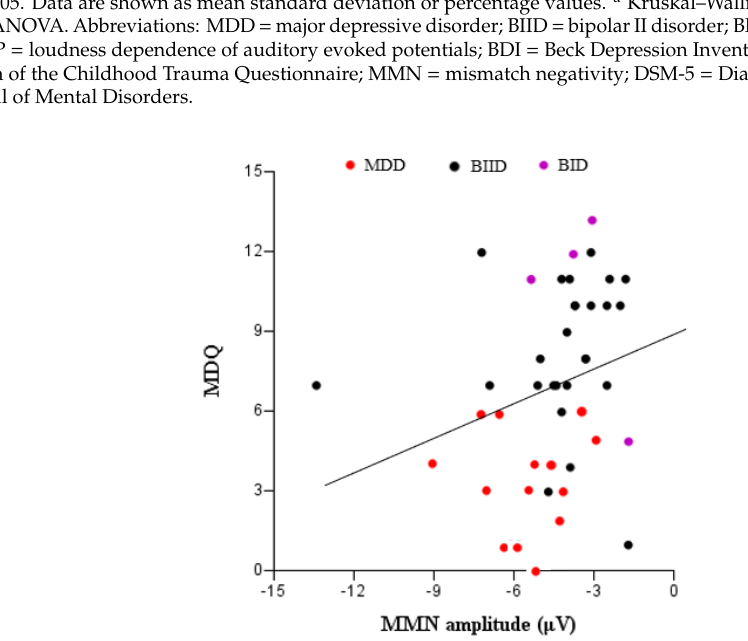
Figure 2. Correlation between LDAEP (loudness dependence of auditory evoked potentials) and MMN amplitude (F3) ( r = −0.30, p = 0.024).